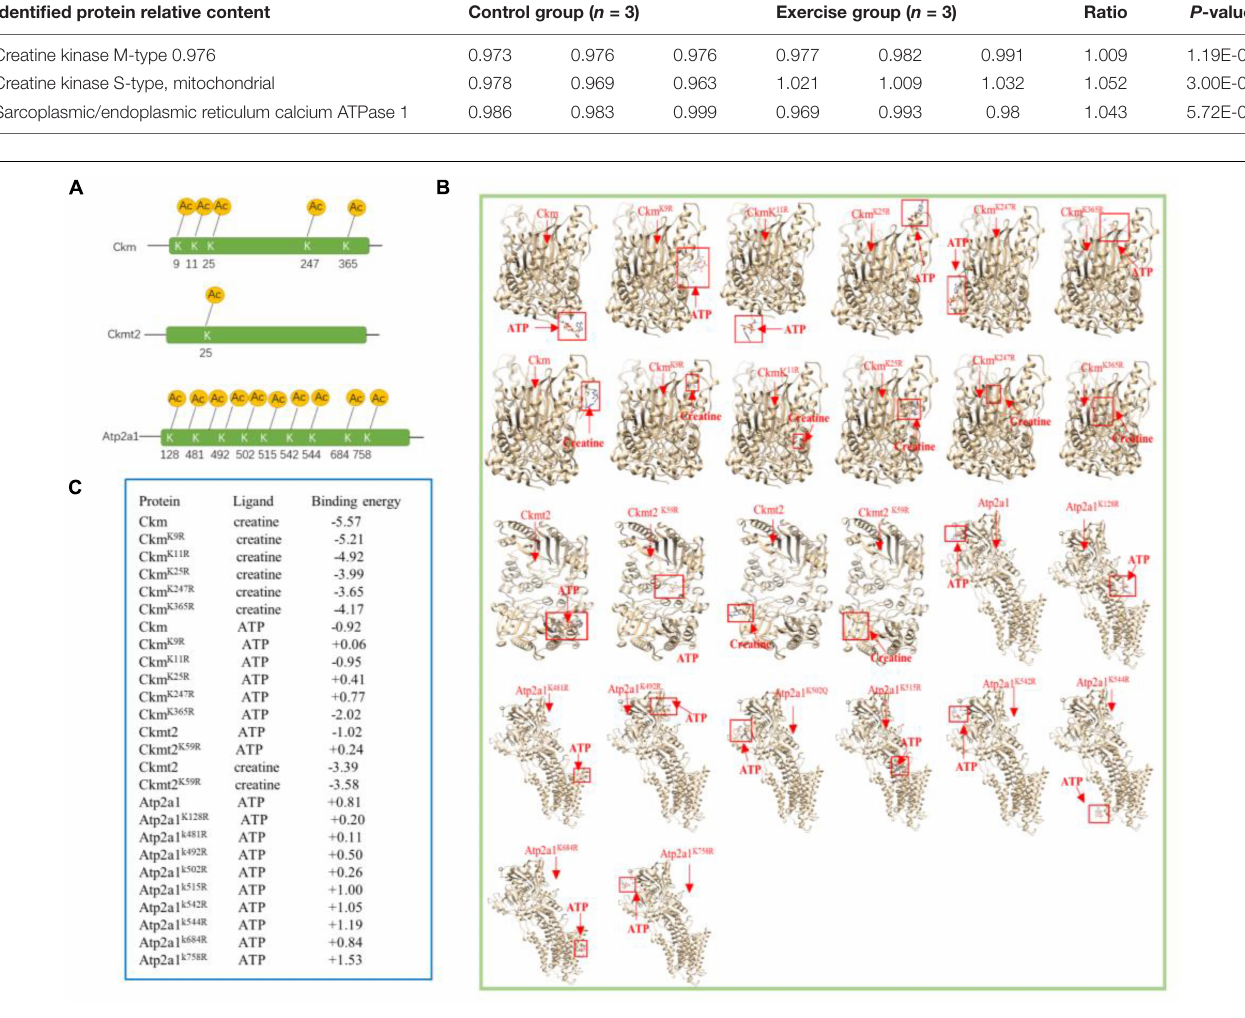
Kac sites in mouse muscle proteins ( Figure 1B ). By